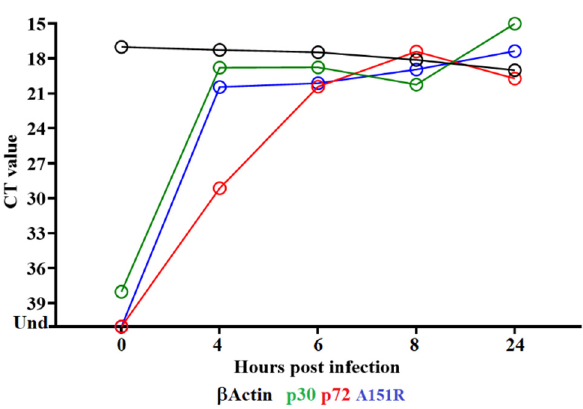
Figure 2. Expression profile of A151R gene of ASFV during in vitro infection of porcine macrophages. Reverse transcription followed by qPCR was used to evaluate the expression profile of the A151R gene during in vitro infection at different time points, up to 24 h. As a reference for this analysis, we used qPCRs to specifically detect the expression of genes encoding ASFV proteins p30 (early expression) and p72 (late expression). Additionally, the β -actin gene was used as a control to evaluate the quality and levels of RNA during the infection at different time points.